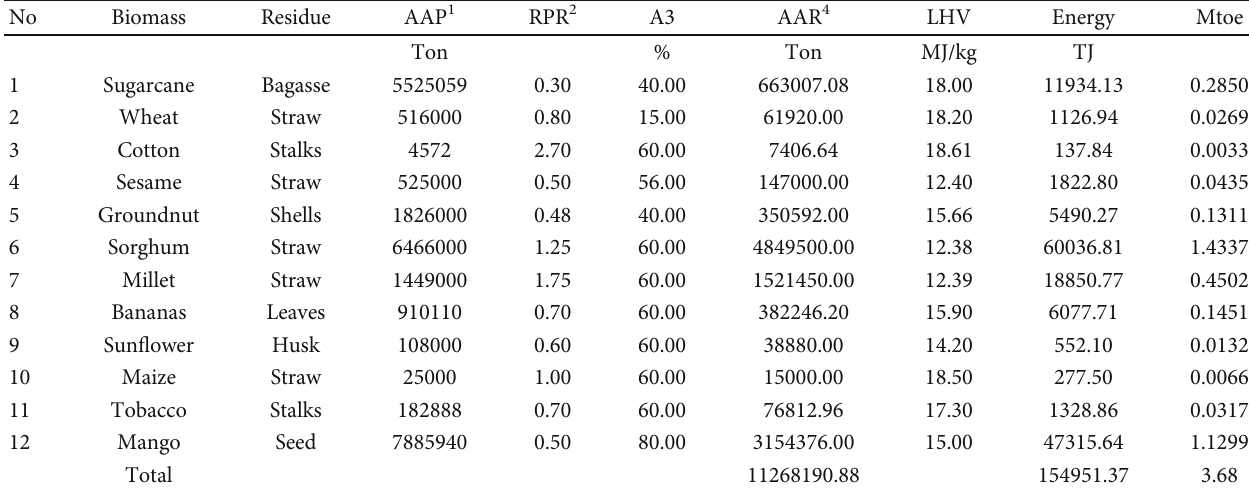
Table 1: Available biomass per year (Sudan) [2 – 4,